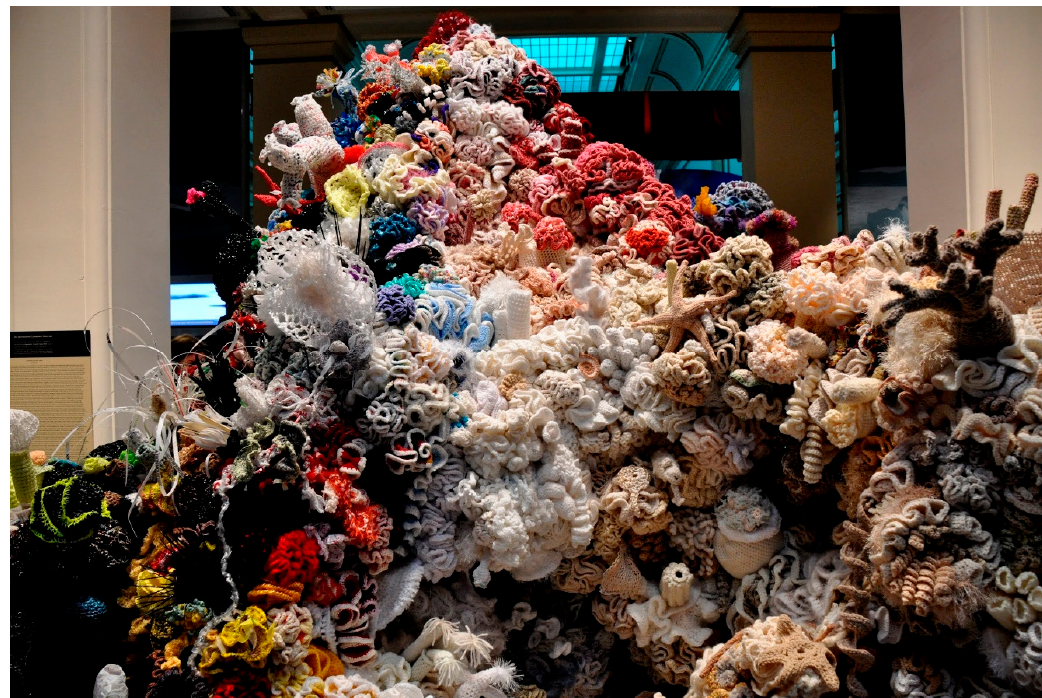
Figure 2. Hyperbolic Crochet Coral Reef exhibit at the Smithsonian’s National Museum of Natural History in Washington, D.C., 2010 (Photo by Ted https://www.flickr.com/photos/frted/5115937870/).